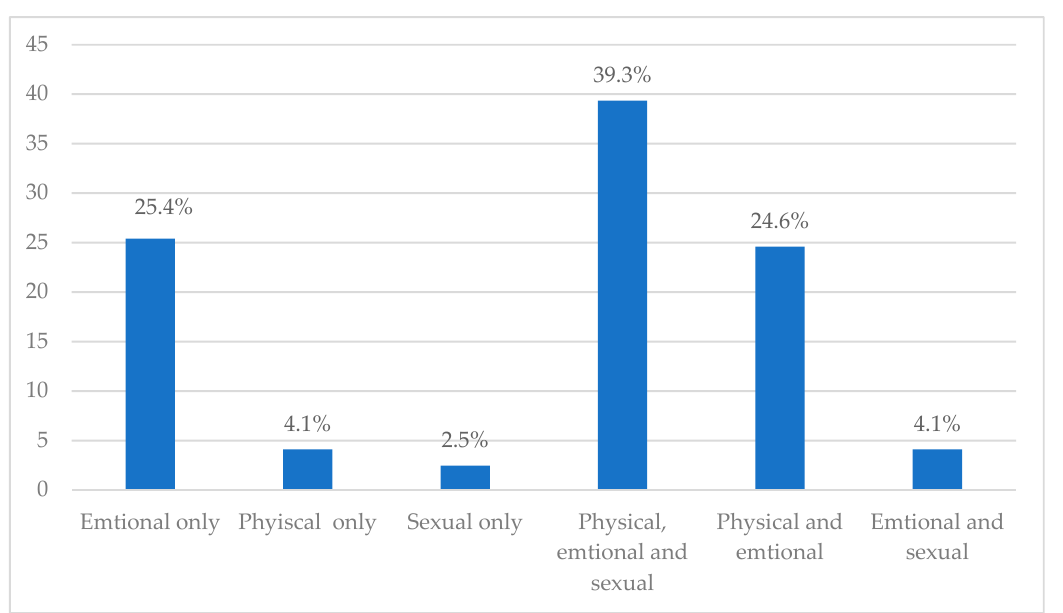
Figure 2. Distribution of different types of IPV among women attending different primary health centers in the Aljouf region, Saudi Arabia.